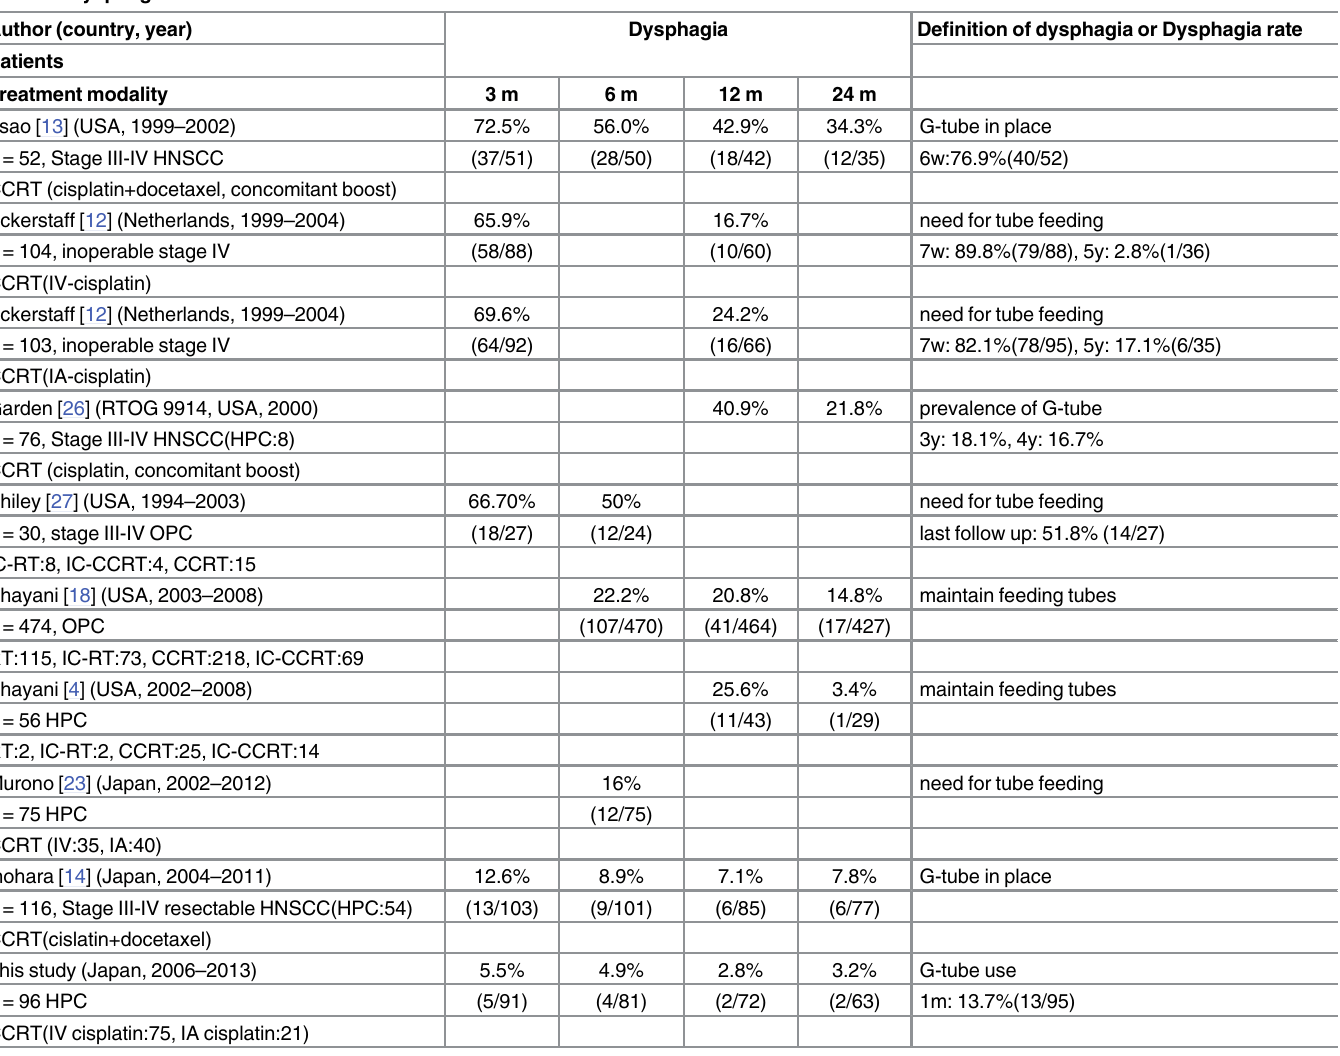
Table 5. Dysphagia after